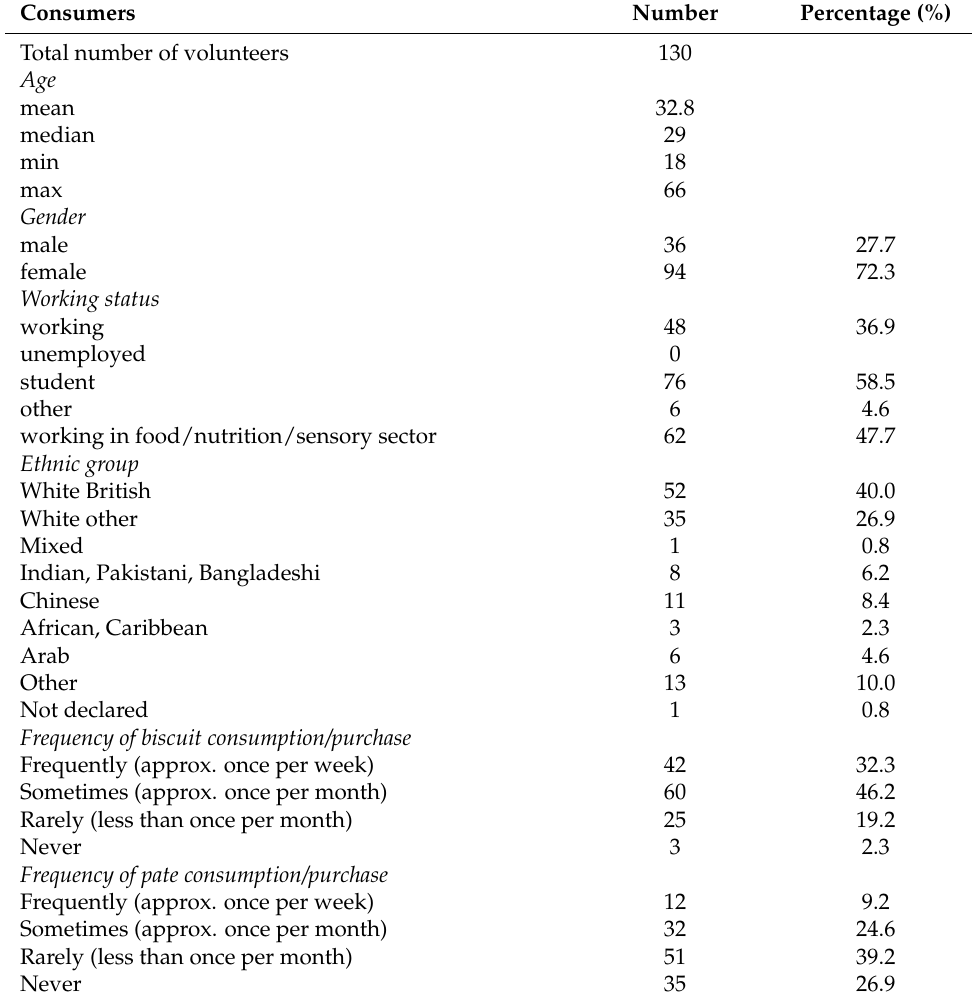
Table 4. Consumer demographics and characteristics of consumer